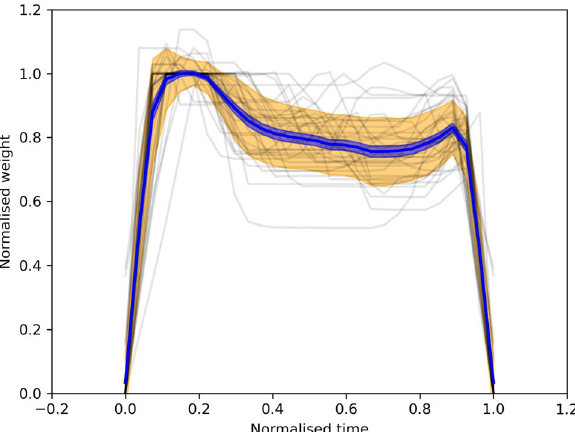
Figure 12. Superposed epoch analysis of 36 weight curves from plate waste disposal. The x-axis represents the normalised time where 0 is the initial placement of the food tray onto the weighing scale and 1 is the removal of the tray. The y-axis represents normalised weight where 1 is the 90th quantile value of the whole weight curve in a given sample.